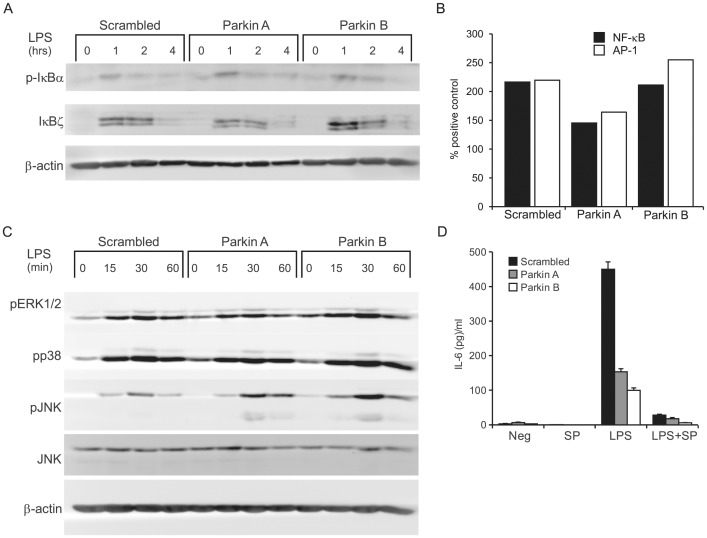
Parkin knockdown effect on NF-κB and MAPK signaling.(A) siRNA-transfected THP-1 macrophages were stimulated with 100 ng/ml LPS for the indicated times, then lysed and analysed by 12% SDS-PAGE followed by Western blotting. Membranes were stained for phospho-IκB-α then reprobed for IκB-ζ and β-actin (B) Nuclear extracts were also analyzed by transcription factor ELISA. THP-1 cells were treated with 100 ng/ml LPS for 4 hours, then extracted and analysed for NF-κB (p65) and AP-1 (phospho-c-Jun) binding to consensus DNA oligomers. Values are expressed as % binding of positive standard extracts and are representative of three experiments. Extracts from diluent (RPMI)-treated cells did not show DNA binding above background. (C) Membranes were stained for phospho-ERK1/2, phospho-p38 and phospho-JNK then reprobed for total JNK and β-actin. The JNK2 (p54) isoform is predominantly detected in these lysates although some phospho-JNK1 (p46) bands can be observed. Blots are representative of at least three experiments. (D) Transfected cells were pretreated with 30 µM JNK inhibitor SP600125 (SP) for 1 hour and then treated with LPS or diluent for 6 hours. IL-6 from the supernatants was measured by ELISA.